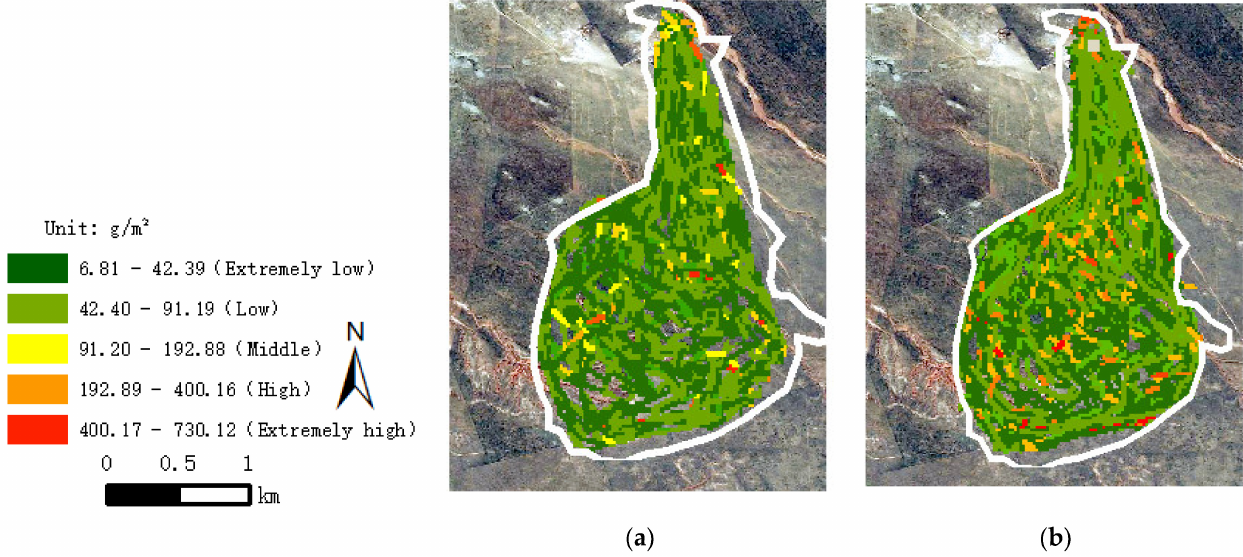
Figure 9. The grazing intensity distribution of sheep in typical months based on constant daily feed intake. ( a ) Summer. ( b )